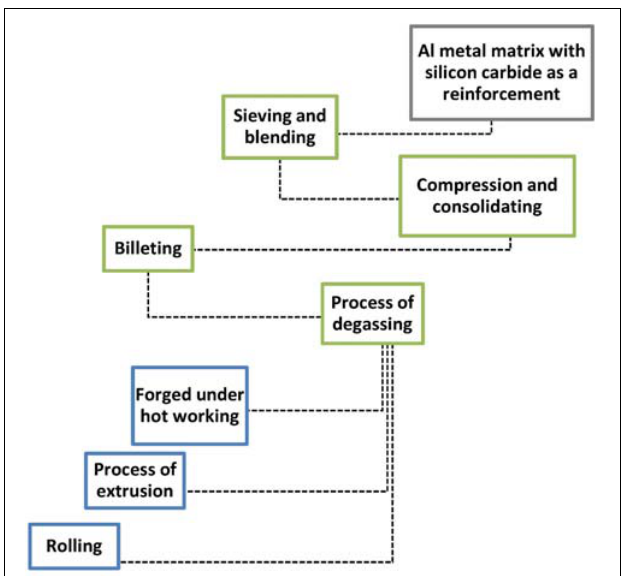
FIGURE 2 | Further processes after casting of Aluminum MMC with SiC addition by stir casting